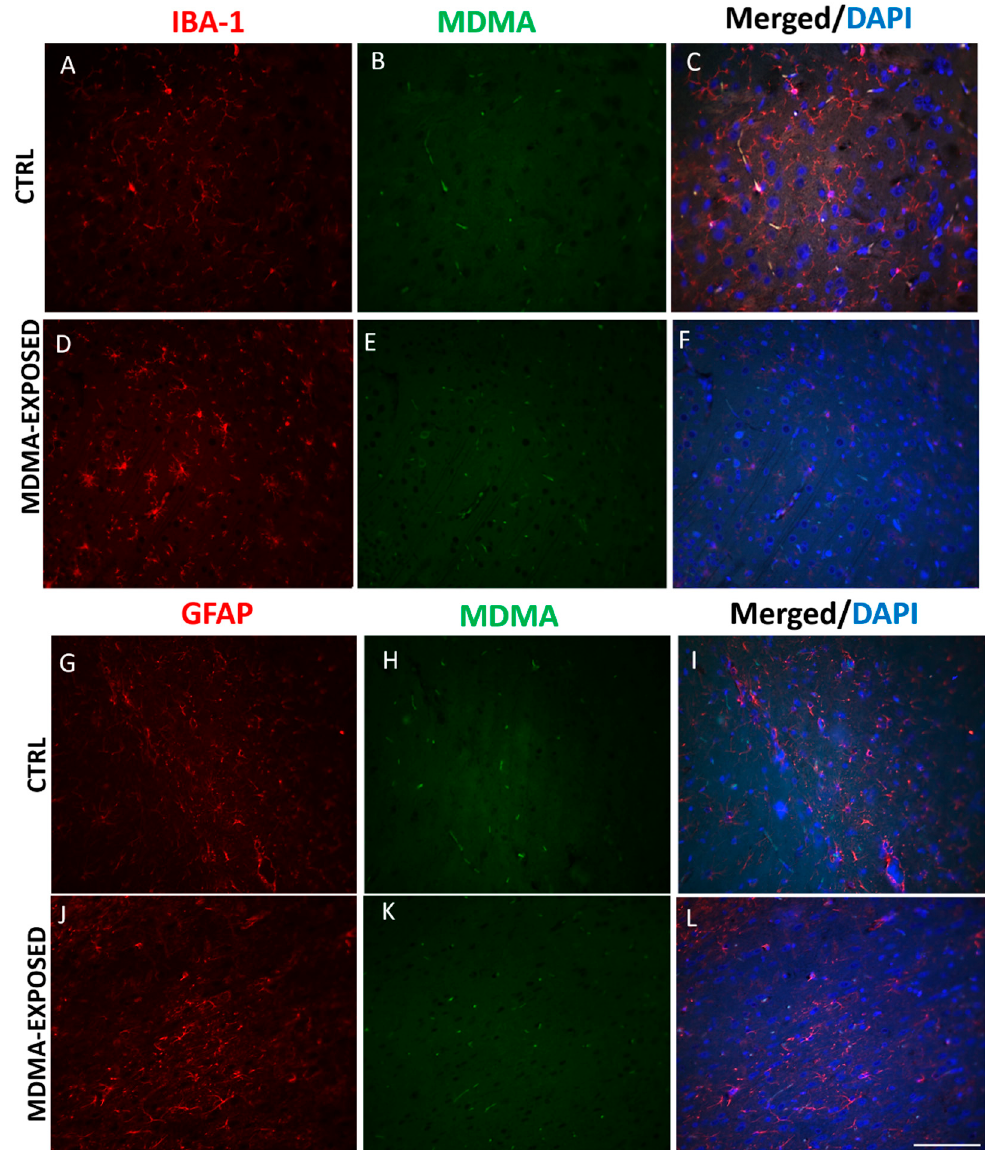
Figure 5. MDMA immunofluorescence is not present in microglia and astrocytes. ( A – F ) Representative immunofluorescence images (light microscopy, 40×) of ionized calcium-binding adapter molecule 1 (IBA-1) (red staining)/MDMA (green staining) and merged images with DAPI (blue staining) in the frontal cortex of ( A – C ) saline-exposed (CTRL) and ( D – F ) MDMA-exposed (sacrificed after 6 h from its administration) rats. ( G – L ) Representative immunofluorescence images (light microscopy, 40×) of glial fibrillary acidic protein (GFAP) (red staining)/MDMA (green staining) and merged images with DAPI (blue staining) in the frontal cortex of ( G – I ) saline-exposed (CTRL) and ( J – L ) MDMA-exposed (sacrificed after 6 h from its administration) rats. Scale bar for images in panels ( A – L ) = 100 µ m. No colocalization was detected between IBA-1 and NT immunofluorescence as well as between GFAP and NT staining (Figure 6A–L and Figure